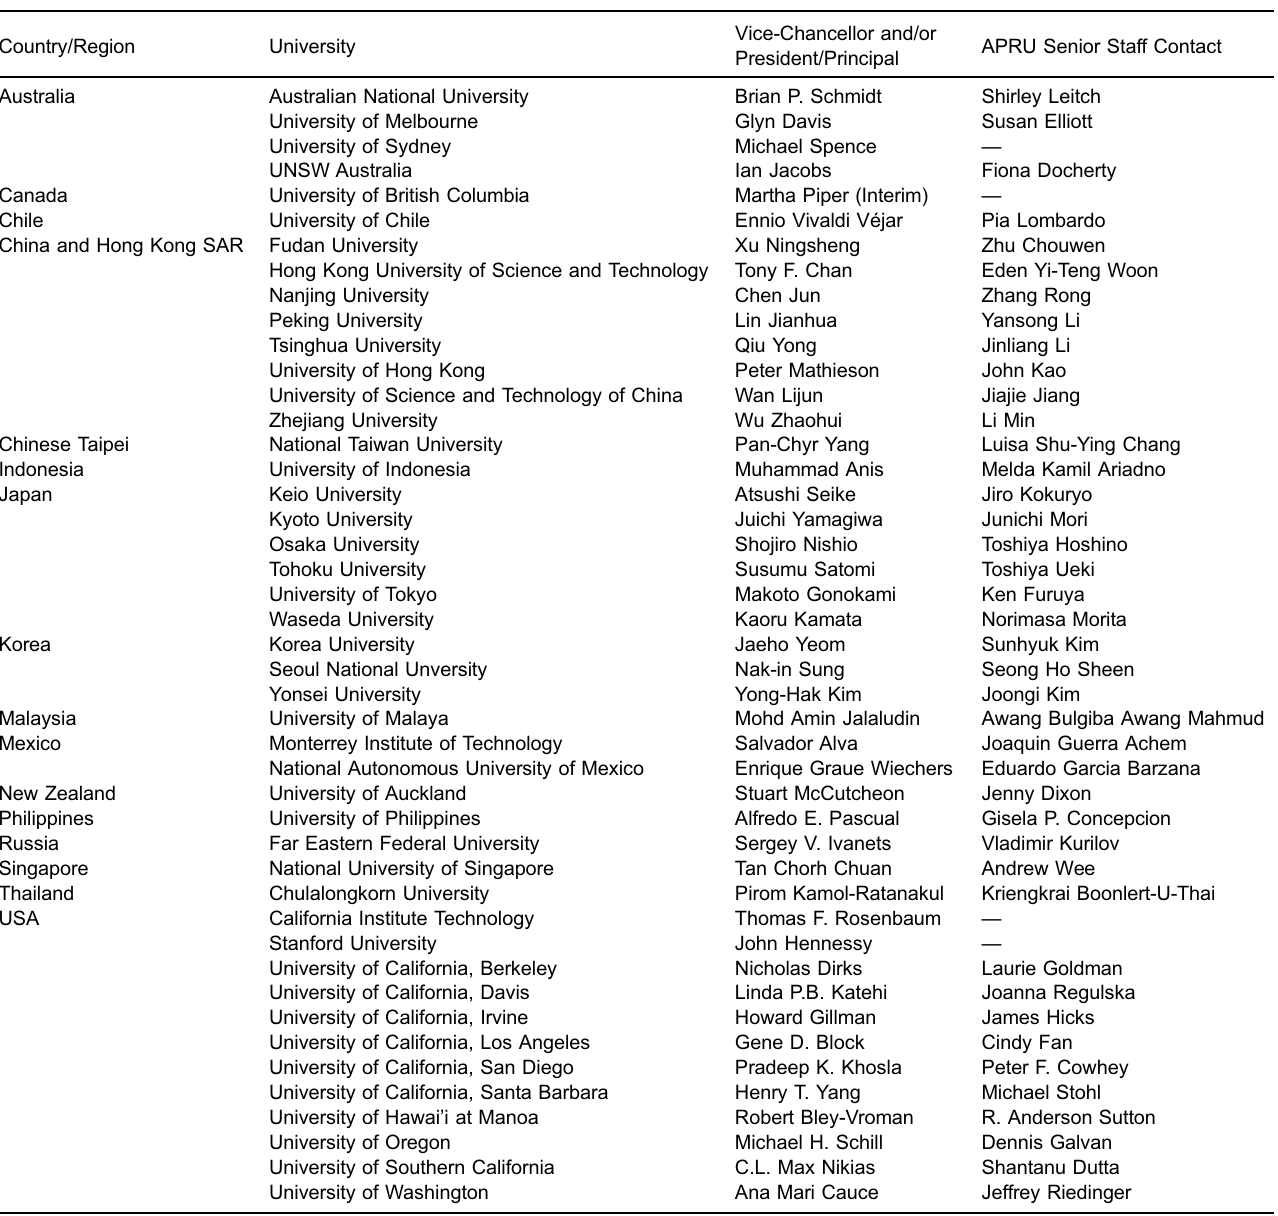
Table 2. Member Universities by region